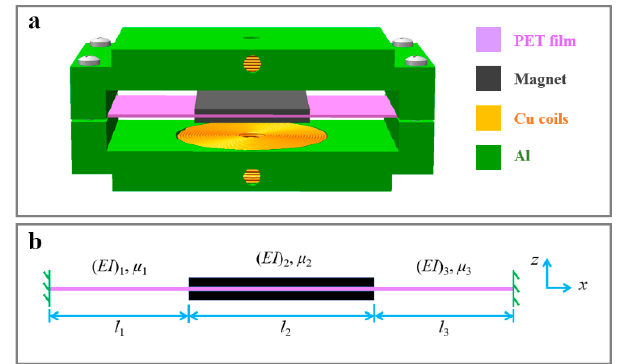
Figure 3. Lu et al. [50] proposed ( a ) a schematic diagram and ( b ) a vibration structure of a nonlinear electromagnetic vibration energy harvester (n-EVEH) based on a double-clamped beam.